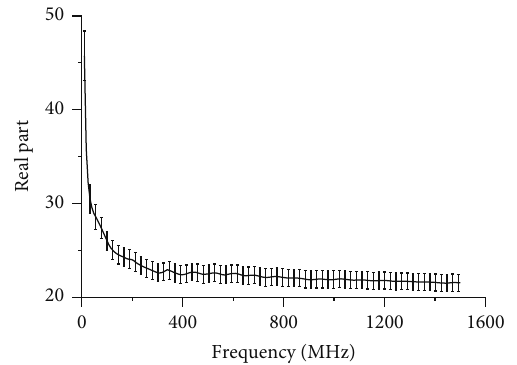
Figure 4: The real part statistical characteristic of sample #5 dielectric permittivity under di ff erent frequency